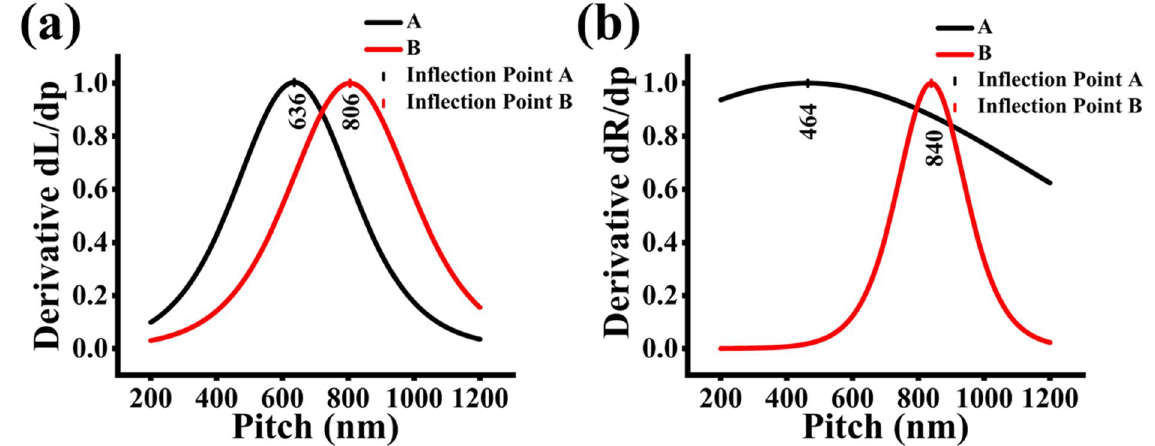
Figure 11. The first derivative of Boltzmann sigmoidal fit results for sample A and sample B for ( a ) length and ( b ) radial extension,